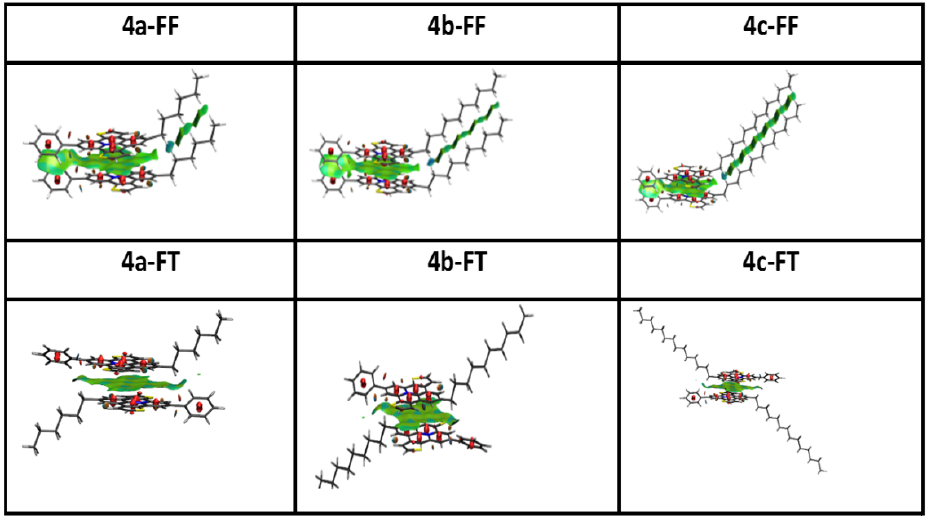
Figure 9. Face-to-face (FF) and face-to-tail (FT) π -stacked dimers of cations from 4 a – c , with non- covalent interactions obtained from NCI